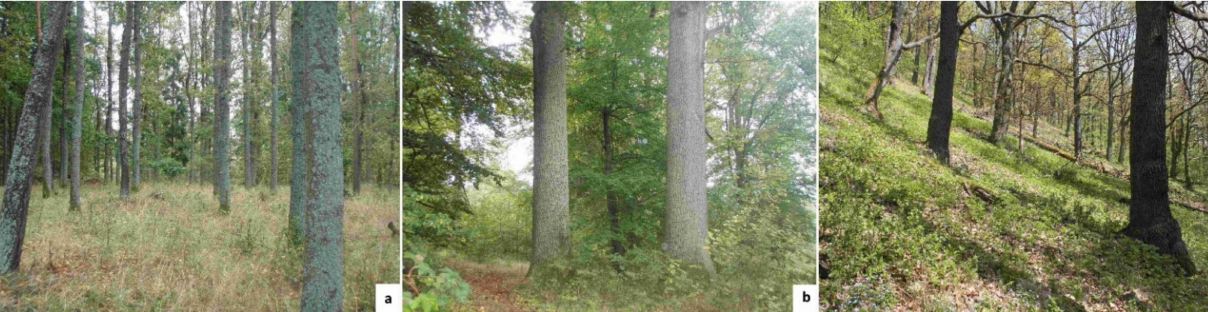
Figure 2. Views of managed 80-year-old oak dominated forests at Holub í n ( a ) and unmanaged oak forests at Kynžvart ( b ) and Vladaˇr ( c